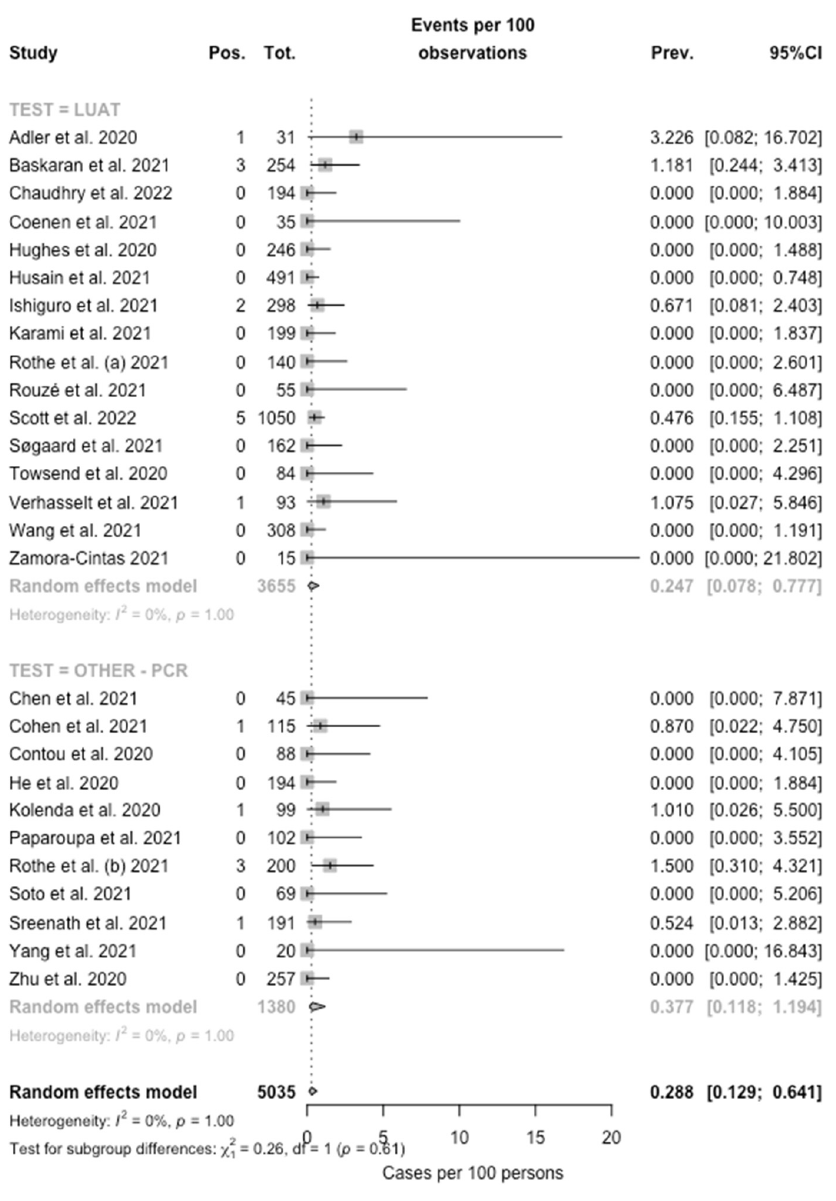
Figure 2. Forest plot representing the estimated pooled prevalence (Prev.) for Legionella infection (Pos.) among individuals affected by SARS-CoV-2 (Tot.). The pooled prevalence rate was estimated at 0.288% (95% Confidence Interval (95% CI) 0.129–0.641), with estimates that were considerably greater in PCR-based studies (0.377%, 95% CI 0.118–1.194) compared to those based on LUAT (0.247%, 95% CI 0.078–0.777).